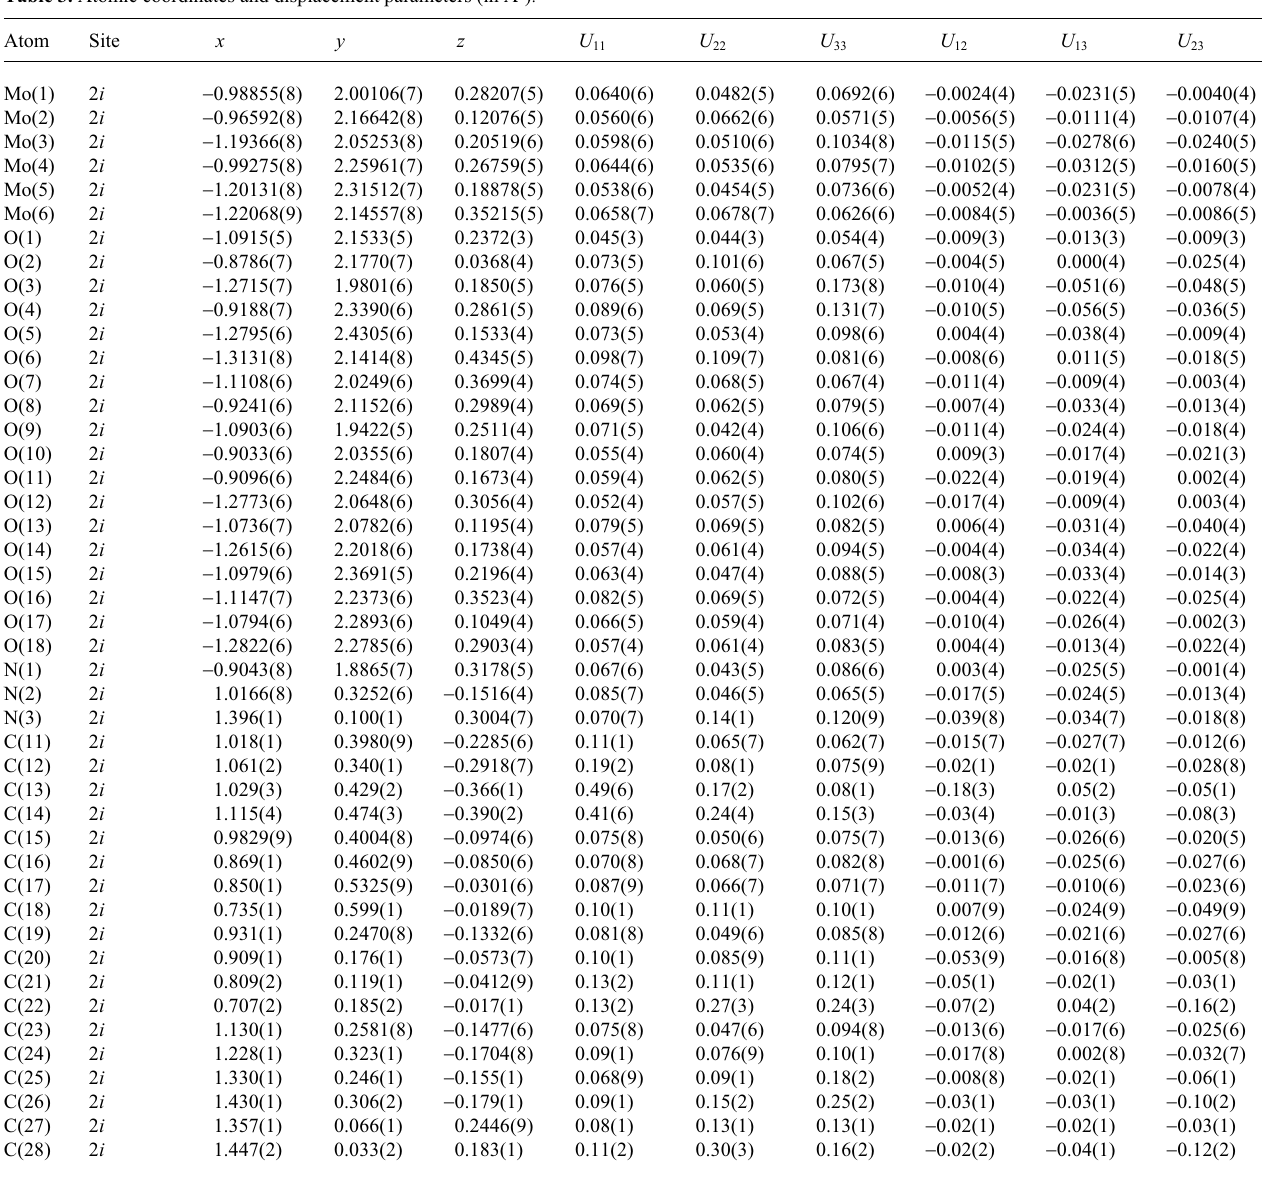
Table 3. Atomic coordinates and displacement parameters (in Å 2 )